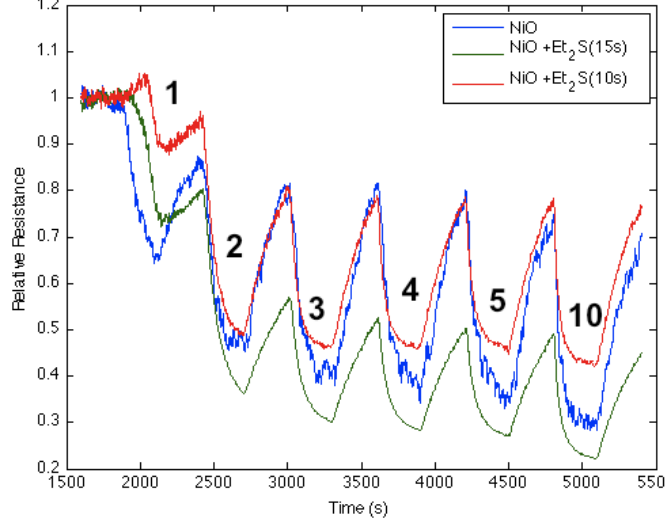
Figure 8. Response of diethyl sulfide-treated nickel oxide nanostructure-deposited porous silicon (PS) interface to NH . Initial response of nickel oxide-treated PS ( blue line ), after 3 treatment for 10 s with diethyl sulfide ( red line ), and after treatment for 15 s with diethyl sulfide ( green line ). The Et S-treated NiO-deposited interface treated for 15 s is a weaker 2 Lewis acid made more basic relative to the PS- and NiO-treated (Figure 1) PS